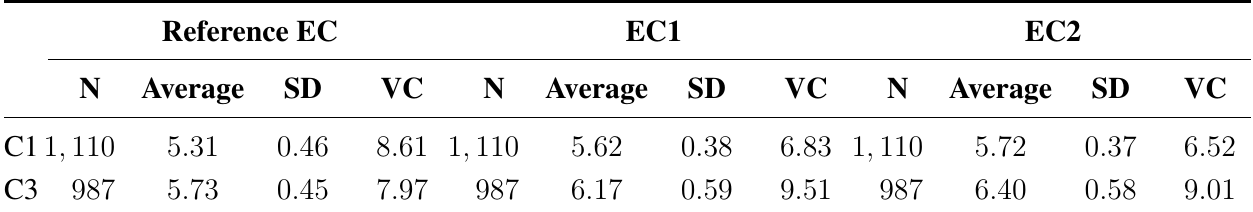
Table 6. Electrical conductivity (EC, mS/cm) of samples analyzed during on-line milking parlour